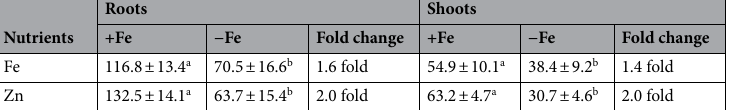
Table 1. Determination of Fe and Zn concentrations (µg g −1 DW) in roots and shoots of sunflower cultivated under Fe-sufficient and Fe-deficient conditions. Data represent means ± SD of three independent biological samples. Different letters indicate significant difference at P < 0.05 level.